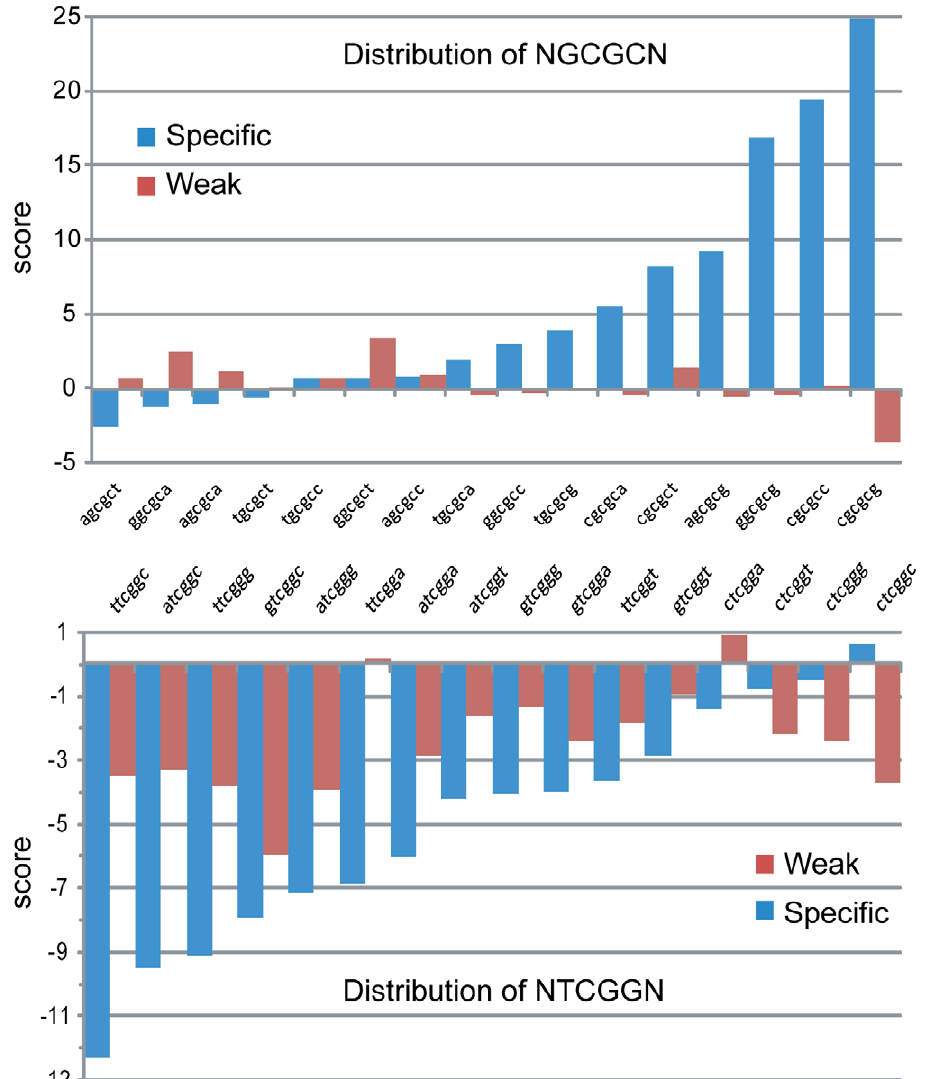
Figure 6. Human CpG islands show evidence of selection at methylation signature motifs. The distribution of predicted DNMT3B methylation coldspots (5 9 -NGCGCN-3 9 , top) and hotspots (5 9 -NTCGGN-3 9 , bottom) was analyzed in two datasets corresponding to all ‘‘specific’’ and all ‘‘weak’’ CpG islands from human chromosome 1, respectively. The score on the y-axis represents the exceptionality of the frequency of a given motif. A positive score indicates an over-representation of a motif in a given model of the sequence (the M1 model, which computes expected motifs frequencies based on mono- and di-nucleotide frequencies was used here). A negative score indicates under-representation. A higher absolute score value indicates a greater statistical significance (a score of 5 corresponds to a p-value of , 10 2 6 , which starts to be considered significant; a score of 10 corresponds to a p-value of , 10 2 23 ).